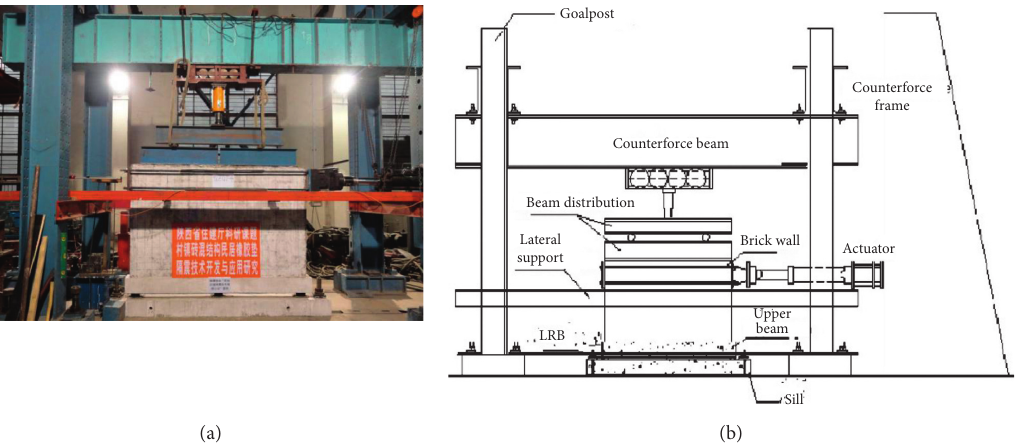
Figure 2: Bearing wall experiment loading device: (a) photo; (b)